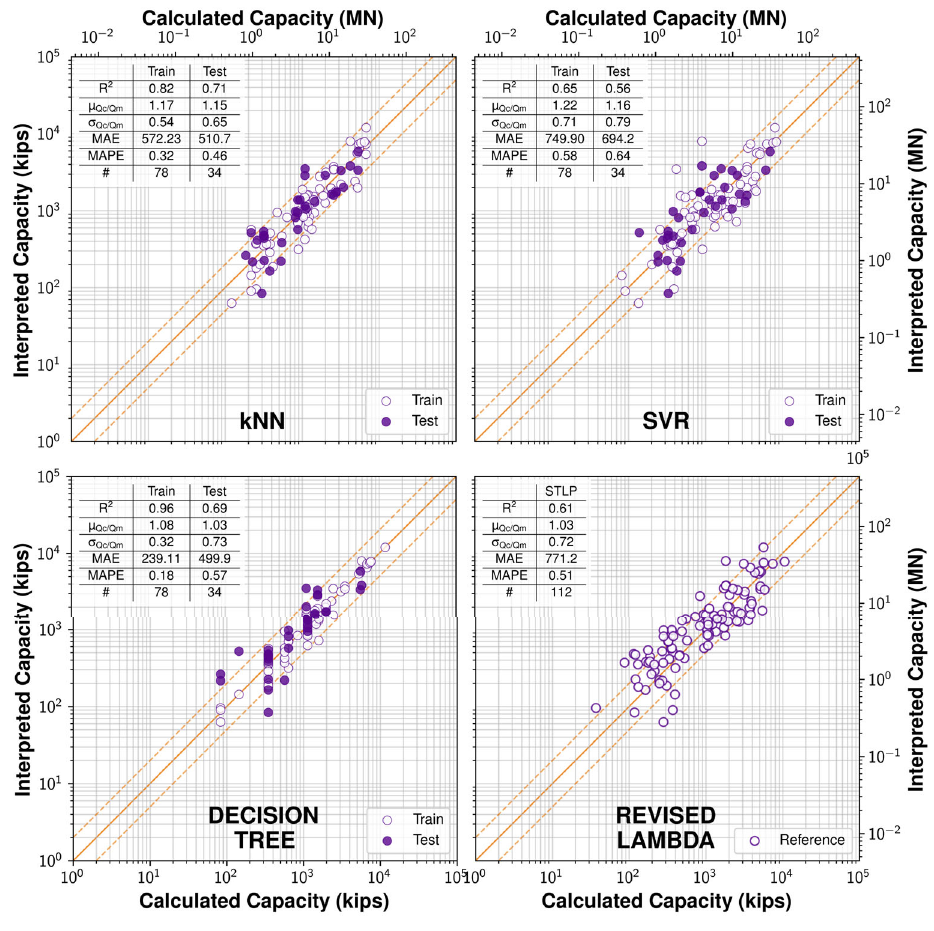
Figure 6. Performance of best-performing methods using only the pile dimensions as input. (1:1, 1:0.5, and 1:2 lines are shown in orange)